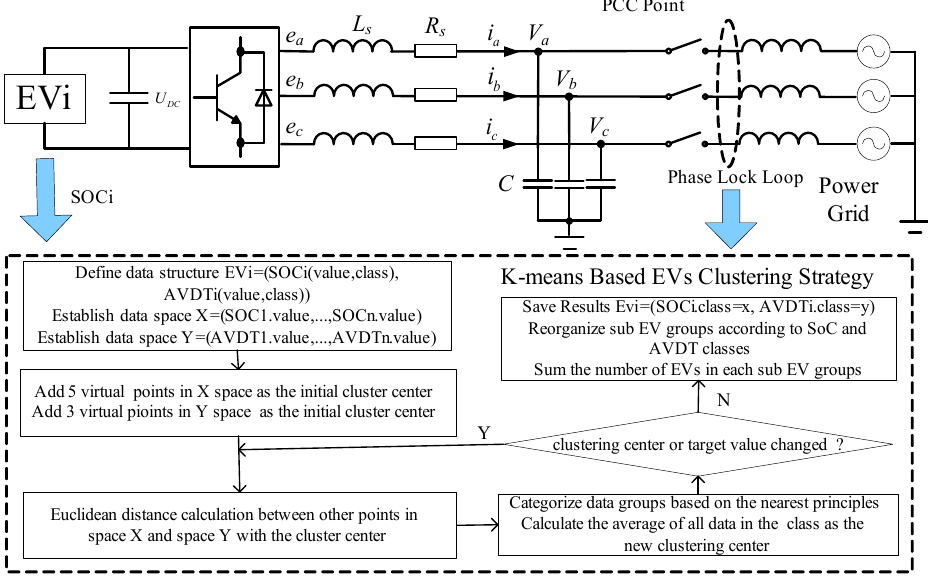
Figure 2. K-means based EVs clustering